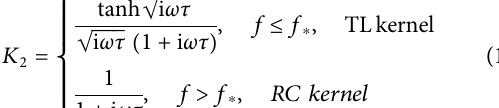
FIGURE3| DRT(solidline,bluestars,leftaxis)andimaginarypartof RC - circuit impedance 1/(1 + 10 − 2 i ω ) (blue dots, right axis) calculated with Eq. 16 and α (cid:1) 1 for all frequencies. Open red circles show imaginary part reconstructed from the calculated DRT using Eq. 16 . Dashed red line plots α (cid:1) 1 for this calculation.